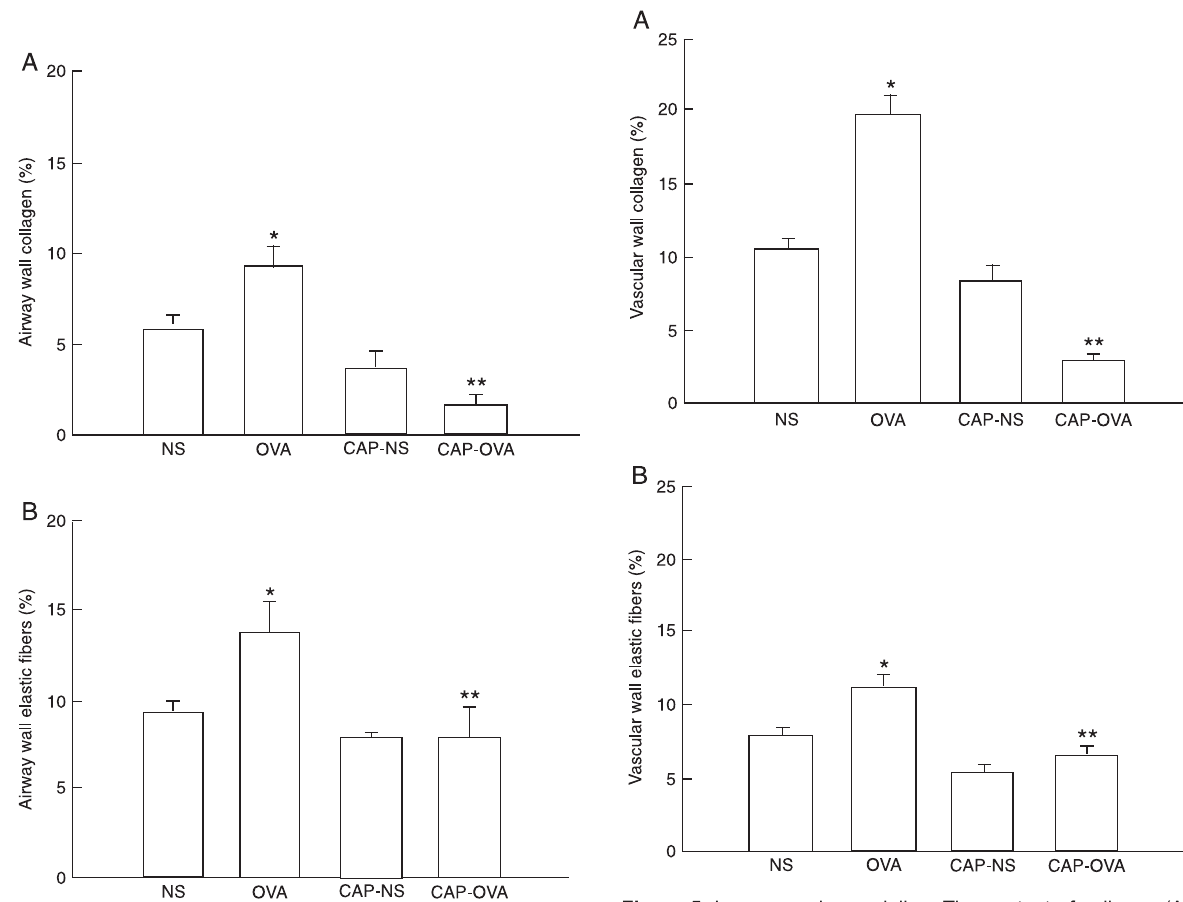
Figure 5. Lung vessel remodeling. The content of collagen (A) and elastic fibers (B) in the vascular wall of guinea pigs (means and SEM) submitted to seven inhalations of ovalbumin (OVA) or normal saline (NS) is represented. Data are reported as percent- age. *P < 0.05 compared with NS-exposed guinea pigs; **P < 0.01 compared with OVA-exposed animals that received vehicle of capsaicin (OVA x CAP-OVA groups). Statistical analysis was done by two-way analysis of variance and multiple comparisons were made using the Holm-Sidak